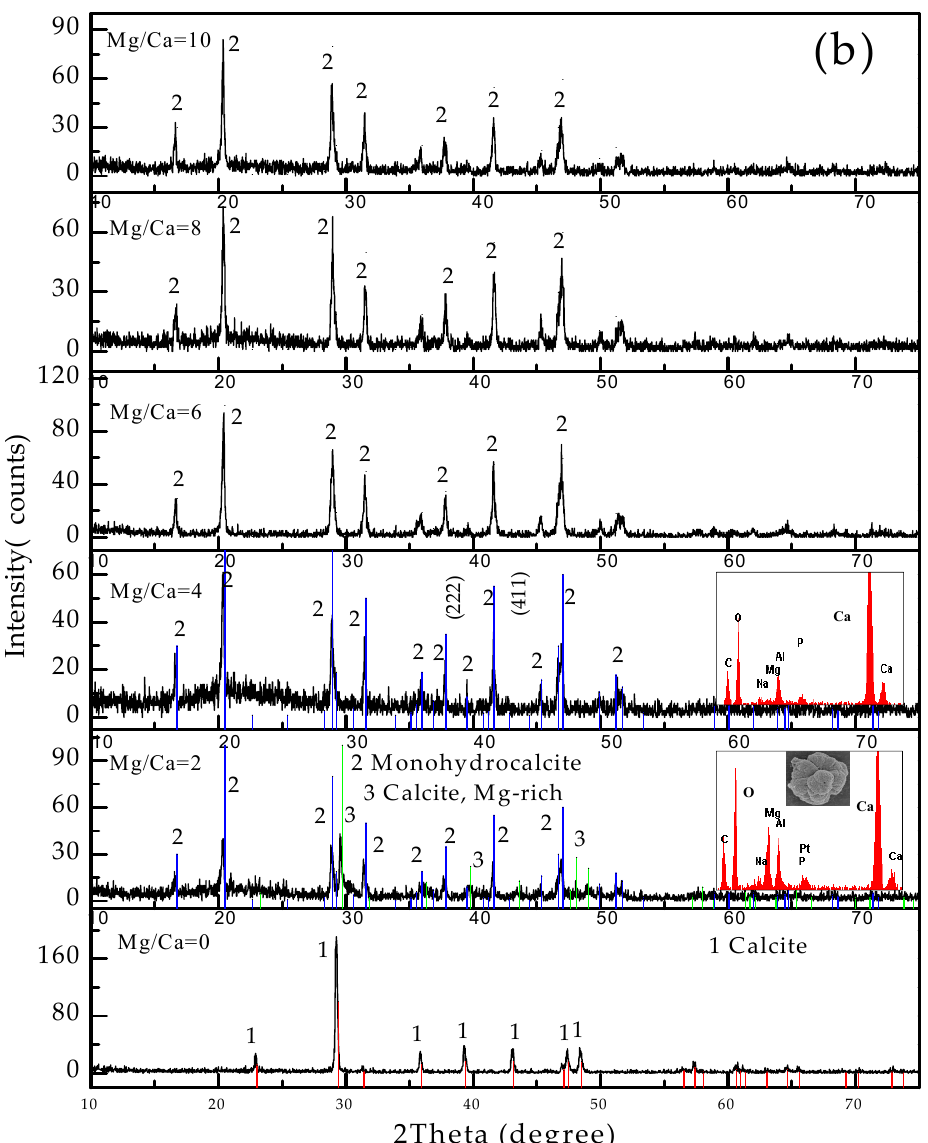
Figure 5. XRD patterns of the minerals in MgSO 4 medium with 15% NaCl and different Mg/Ca molar ratios after 15 days of cultivation: ( a ) the control group; and ( b ) the experimental group. Note: The red line represents the mineral phase of calcite in PDF card 47-1743, the blue line represents the mineral phase of monohydrocalcite in PDF card 29-0306, and the green line represents the mineral phase of Mg-calcite in PDF card 43-0697.